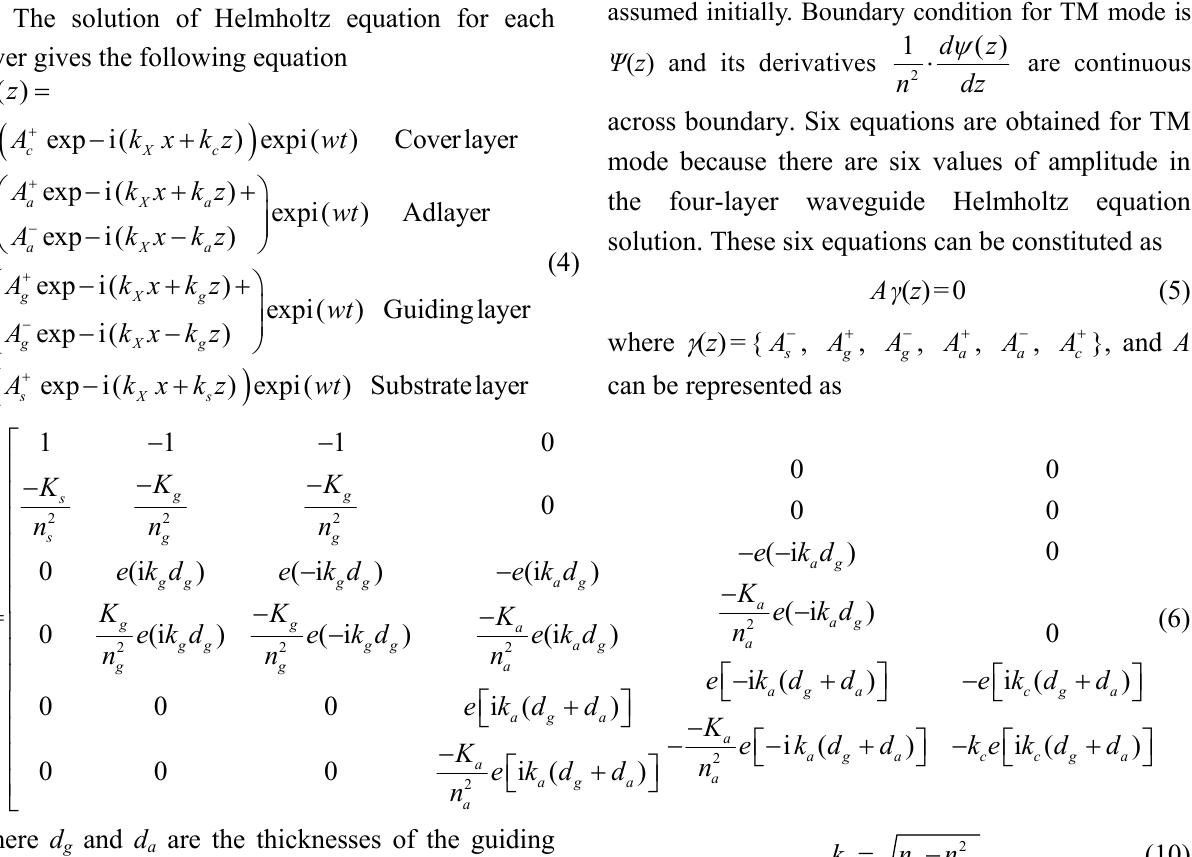
Fig. 1 Schematic diagram of the proposed planar waveguide sensor with an adlayer having refractive index n a and width d a . The refractive indices used are: n s = 1.471, n a = 1.45, 1.50, ( 4 i0.001)( 2.4 i0.001) n      , and n c = 1.33 or g